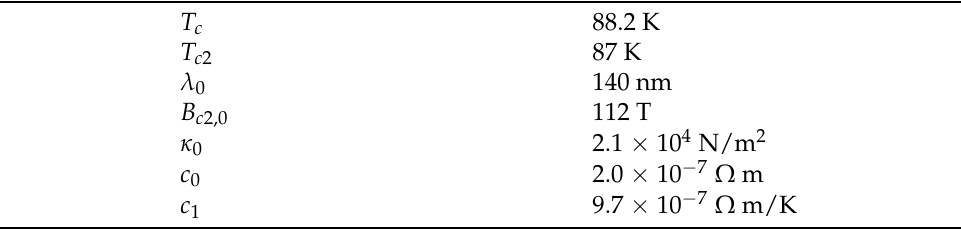
Table 1. Parameters for vortex dynamics